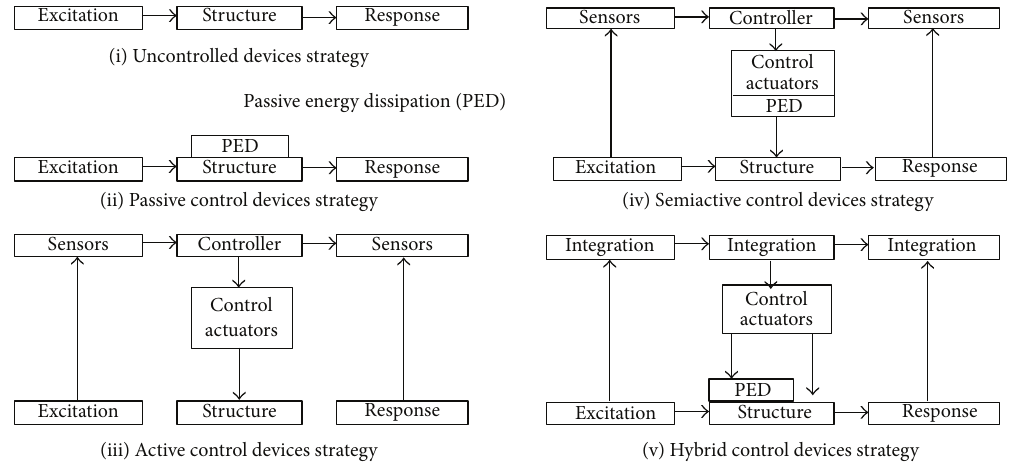
Figure 14: Comparison of control